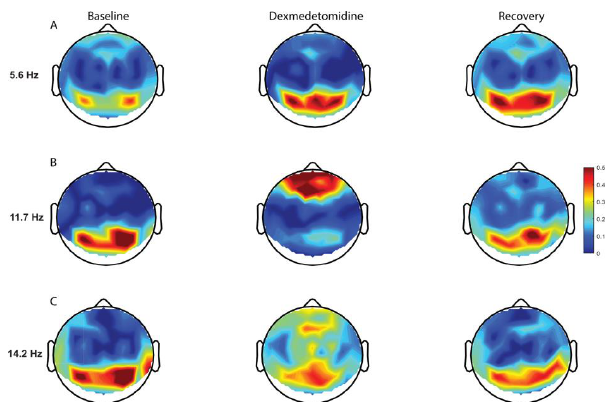
Figure 3. Topographic electroencephalogram maps detailing group-averaged global coherence for each electroencephalogram frequency of interest. ( A ) Dexmedetomidine is associated with increased occipital theta global coherence. ( B ) Dexmedetomidine is associated with a shift in the globally coherent occipital awake alpha to frontal regions. ( C ) Dexmedetomidine is associated with globally coherent fronto-central spindle oscillations [14]. J. Clin. Med. 2020 , 9 , x FOR PEER REVIEW